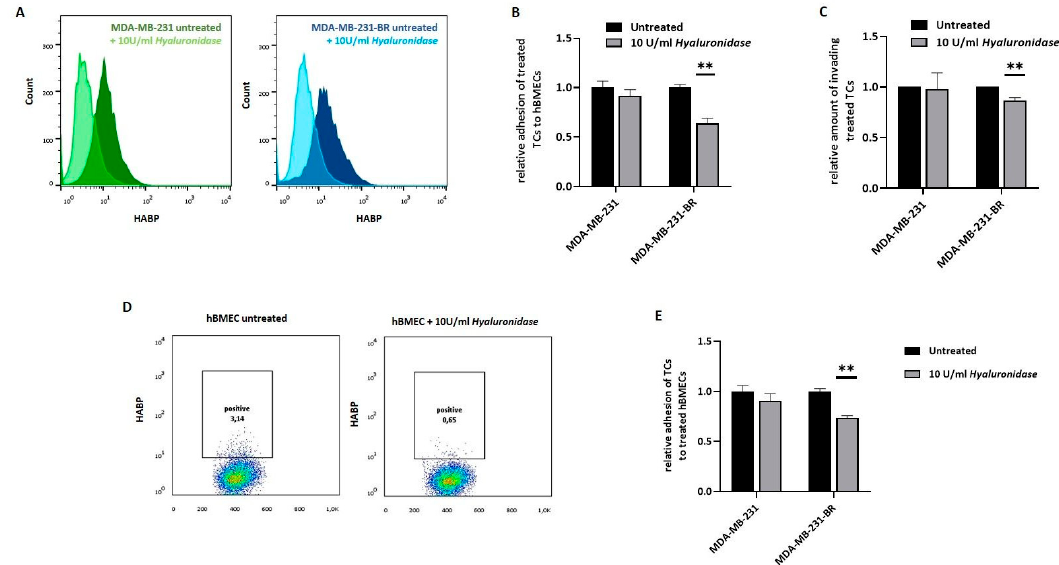
Figure 2. Influence of the pericellular HA-coat on BBB-related adhesion. ( A ) Histogram showing surface HA measured via flow cytometry: for both triple-negative breast cancer (TNBC) cell lines (MDA-MB-231, MDA-MB-231-BR) the histogram shows the HA level in the untreated situation (dark color) as well as after treatment with 10 U/mL hyaluronidases (light color). One representative experiment is shown ( n =2). ( B ) Adhesion of tumor cells (TCs, untreated) and previously treated TCs (10 U/mL hyaluronidase , overnight) to human primary brain endothelial cells (hBMECs) analyzed under static conditions. The relative amount (to untreated control =1) of adhesive TCs is shown (one representative experiment with six replicates out of four experiments is shown ( n = 4)). ( C ) Invasion potential of TCs (untreated) and previously treated TCs (10 U/mL hyaluronidase , overnight) through a brain endothelial cell monolayer was measured in a transwell assay. The relative amount (to untreated control =1) of invasive TCs is shown ( n = 3). ( D ) Dot plots showing the quantified amount of surface HA on hBMECs in the untreated situation as well as after treatment with hyaluronidase (10 U/mL), measured via flow cytometry. One representative experiment is shown ( n = 2). ( E ) Adhesion of TCs to hBMECs (untreated) or previously